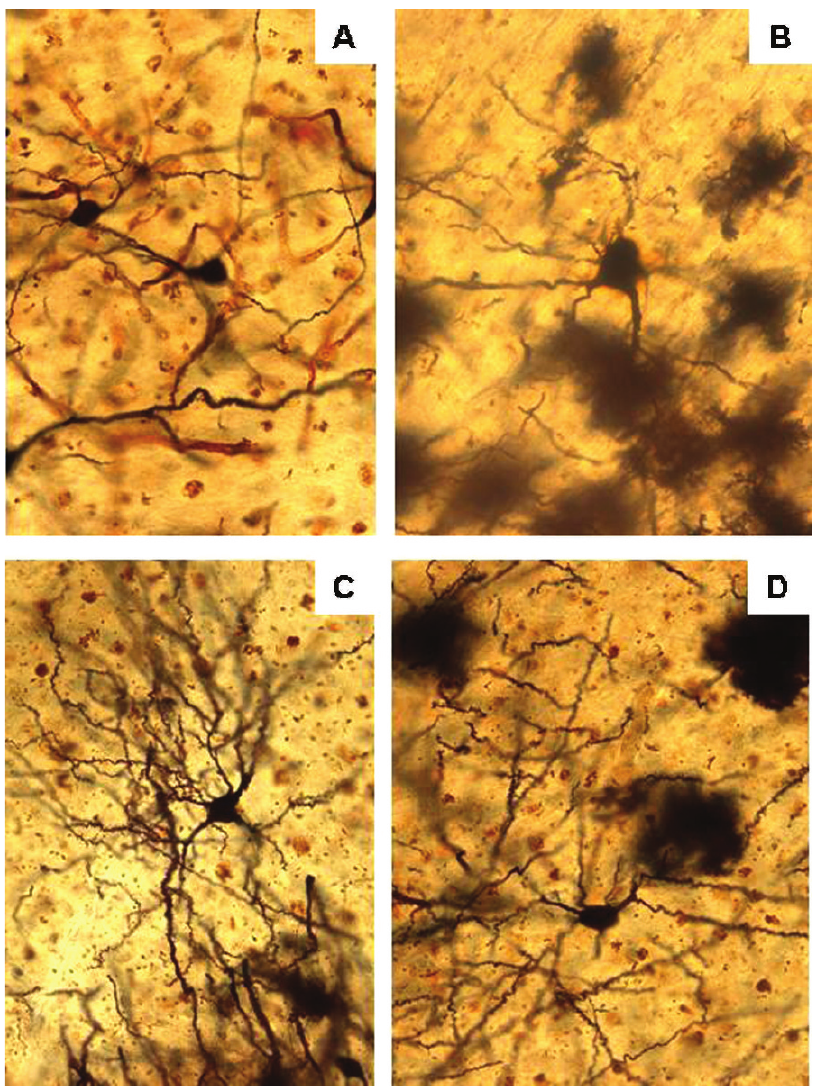
Figure 4 - Photomicrographs of silver-nitrate-impregnated basolateral amygdaloid neurons from control rats A) and rats treated with Bacopa monniera , BM, for 6 weeks at doses of 20 mg/kg B), 40 mg/kg C) and 80 mg/kg D). A significant increase in dendritic arborization in the BM 20-, 40- and 80-mg/kg groups is